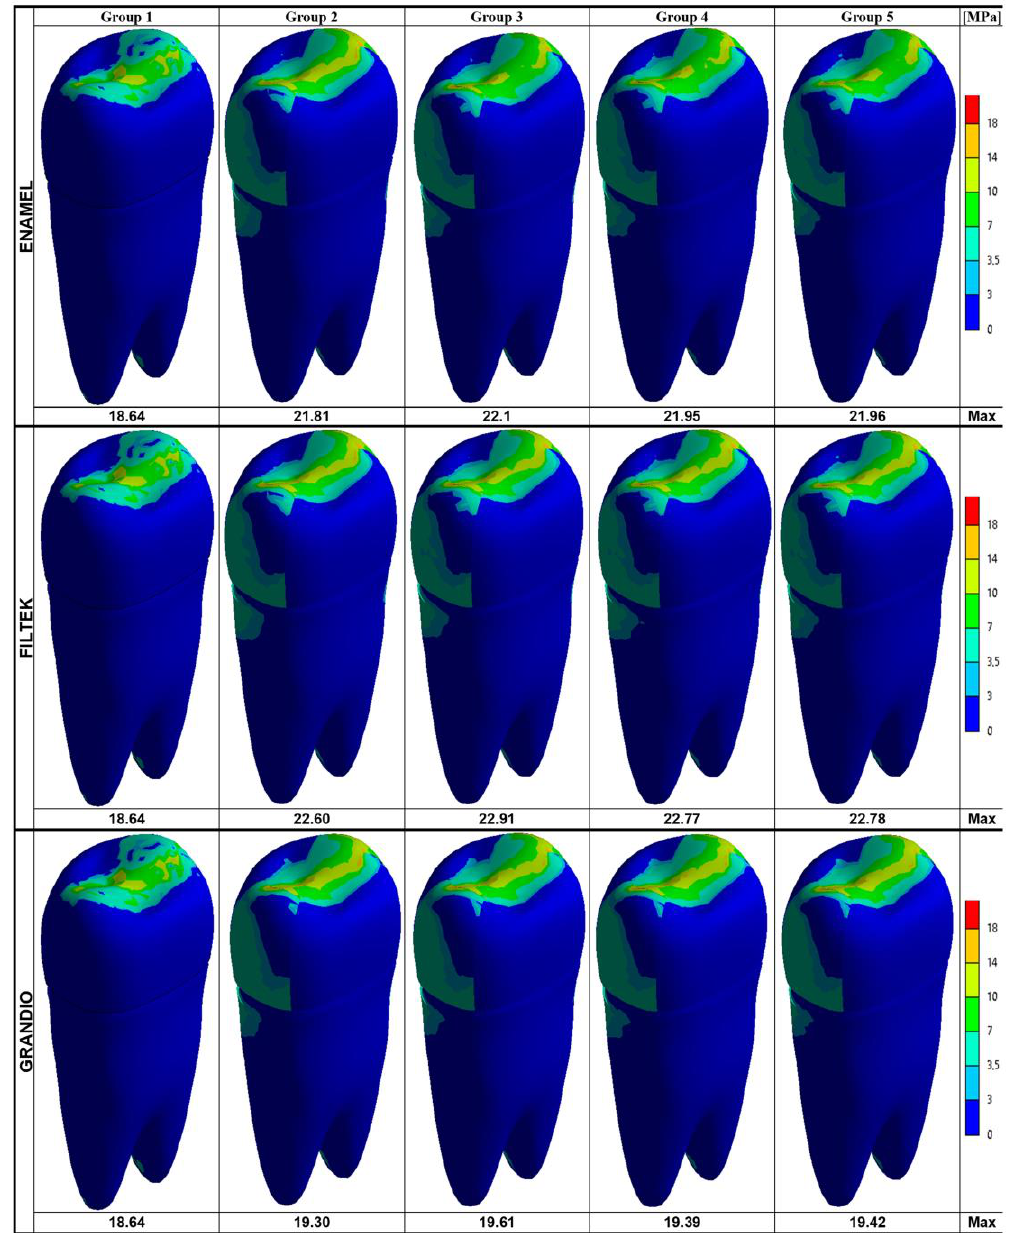
Figure 2. Von Mises maps and Maximum Von Mises stress values (MPa) recorded on the surface of the tooth model. The legend on the right side shows the colors (and the upper and lower limits) corresponding to the seven stress ranks used to analyze the stress distribution.